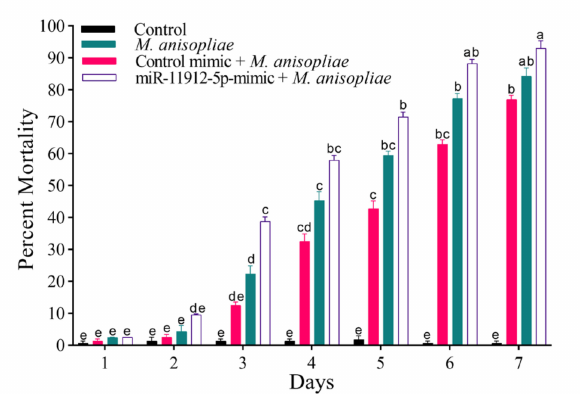
Figure 9. Percent mortality in P. xylostella followed by M. anisopliae infection. Mortality was recorded until seven days after every 24 h. Error bars show 95% confidence intervals (CI). Letters indicate significant differences at p <